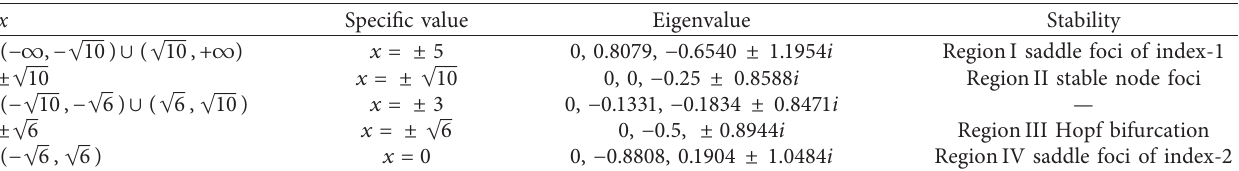
Figure 2: Strange attractor projection on various planes of system (1) with ( a ) � 0.8, ( b ) � 0.5, c � 1, ( d ) � 0.1 under the initial condition IC � (0.01, 0.01, 0, 0). Table 1: The stability of the equilibrium points and corresponding